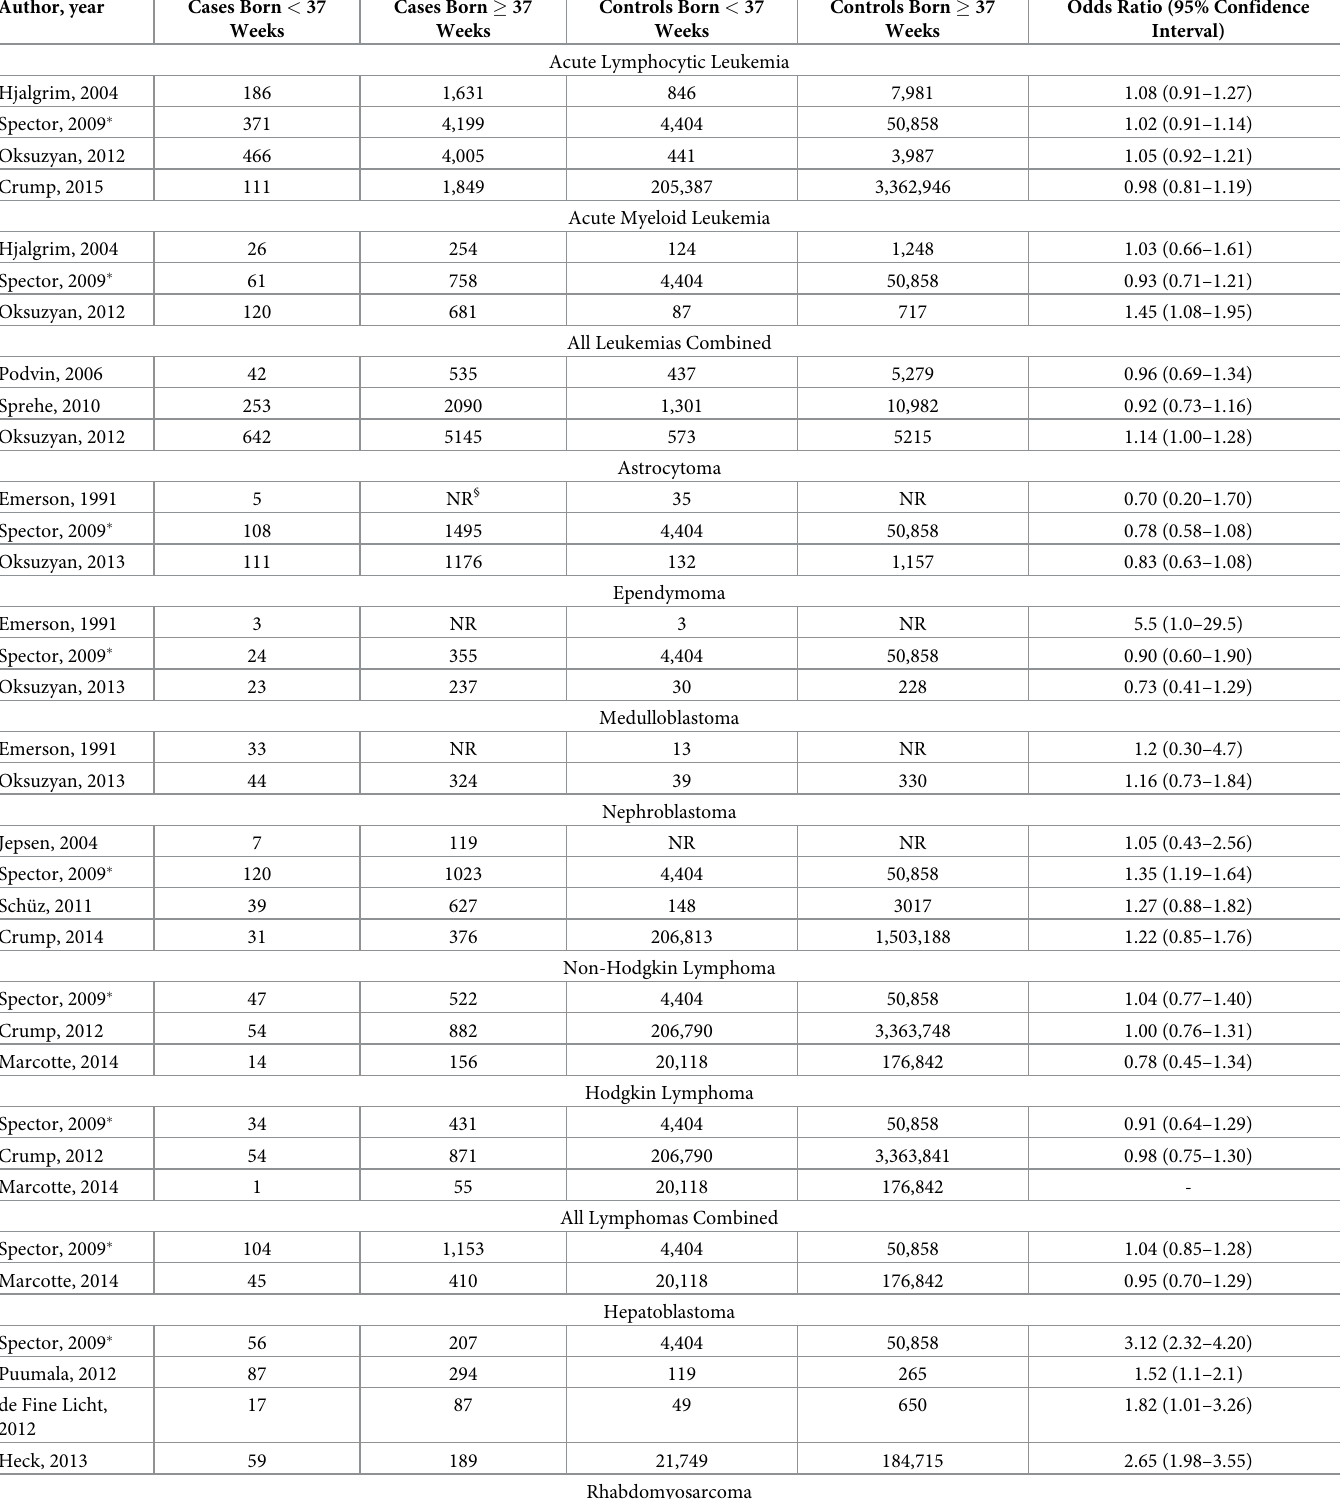
Table 2. Cancer-specific data not amenable to